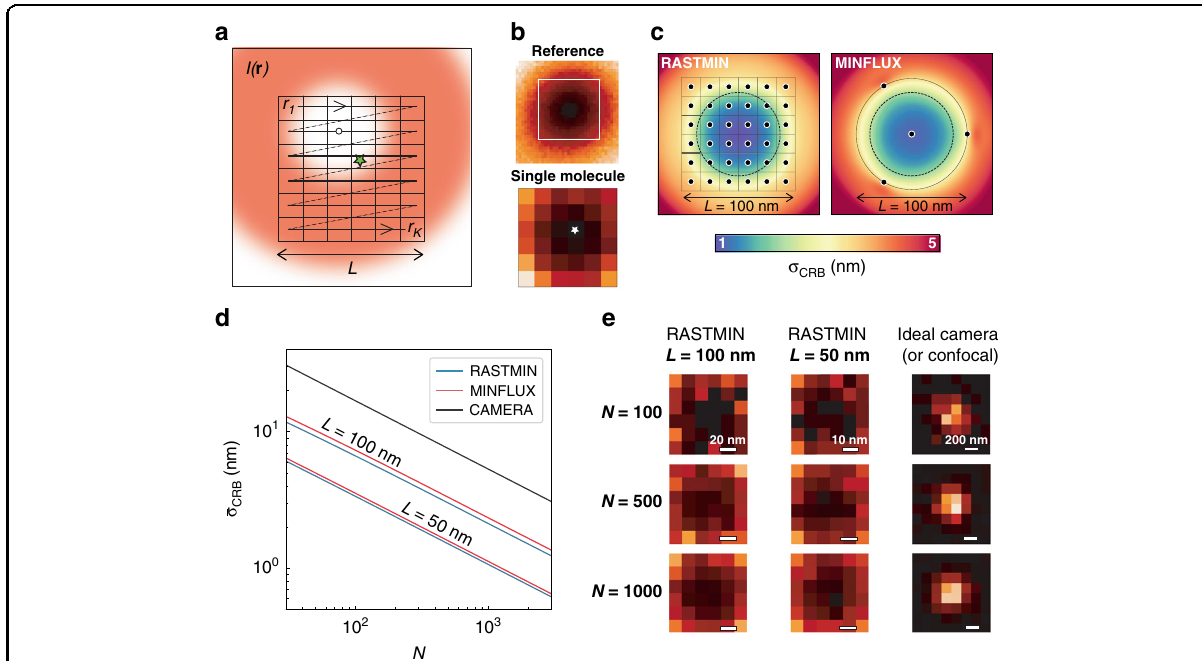
Fig. 1 RASTMIN concept. a Schematic of the RASTMIN measurement: a beam of light with intensity I ð r Þ that features a minimum is raster-scanned over r i ¼ r 1 ; ¼ ; r K pixels de fi ning a region of size L that contains the single emitter (green star). b Two images are acquired: a high-SNR, high- resolution image of the excitation beam (Reference) and a low-SNR, low-resolution image formed by the set of photon counts recorded at each pixel r i (Single molecule). Both images are then used as input to perform a maximum-likelihood estimation of the emitter position. c Theoretical localization precision as a function of the emitter position, σ CRB (x, y), of RASTMIN ( K = 6 × 6) and MINFLUX for N = 1000 and L = 100 nm. d Average precision σ CRB of RASTMIN and MINFLUX over the central area (diameter of 0.75 L ) of the scanned region (black dotted circle in c as a function of N for L = 100 nm and L = 100 nm For MINFLUX, the triangular pattern with a central exposition used in the original publication 26 was used (see Supplementary Section 1 for details). For comparison, also the σ CRB for a camera-based localization without readout noise is displayed. e Exemplary simulated data for a RASTMIN localization at L = 100 nm and L = 50 nm as well as a camera-based localization for different values